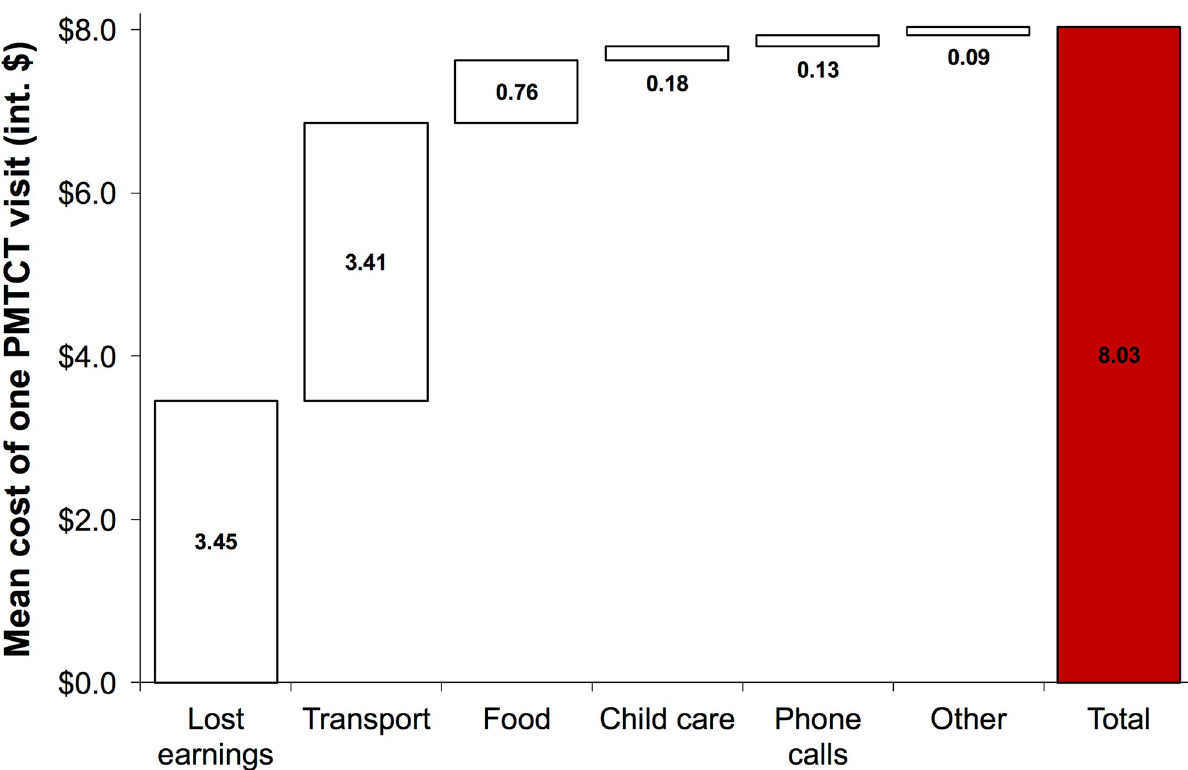
Fig 5. Mean cost to patients of attending 1 prevention of mother-to-child HIV transmission (PMTCT) visit. All monetary values were converted to purchasing power parity-adjusted international dollars (int$) [32]. These questions were answered by 595